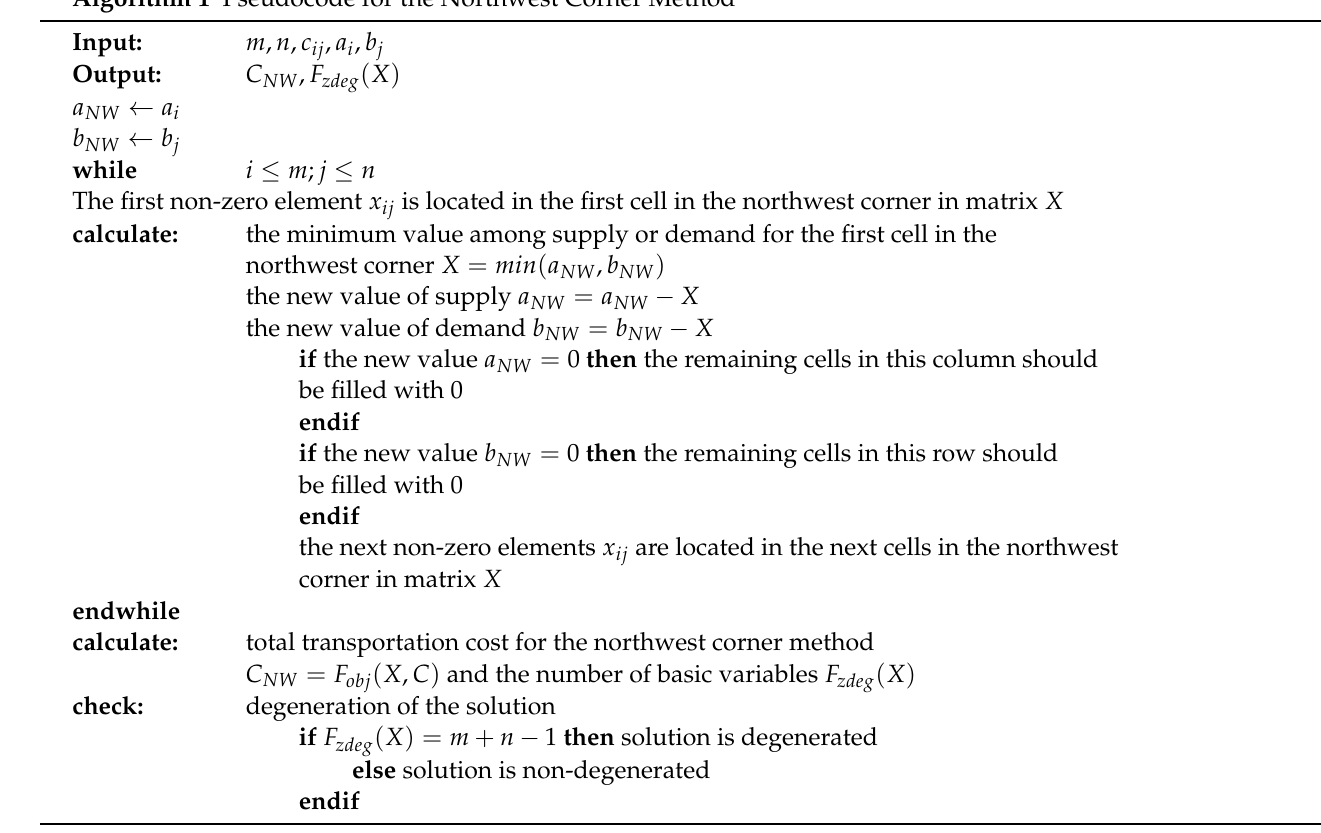
Algorithm 1 Pseudocode for the Northwest Corner